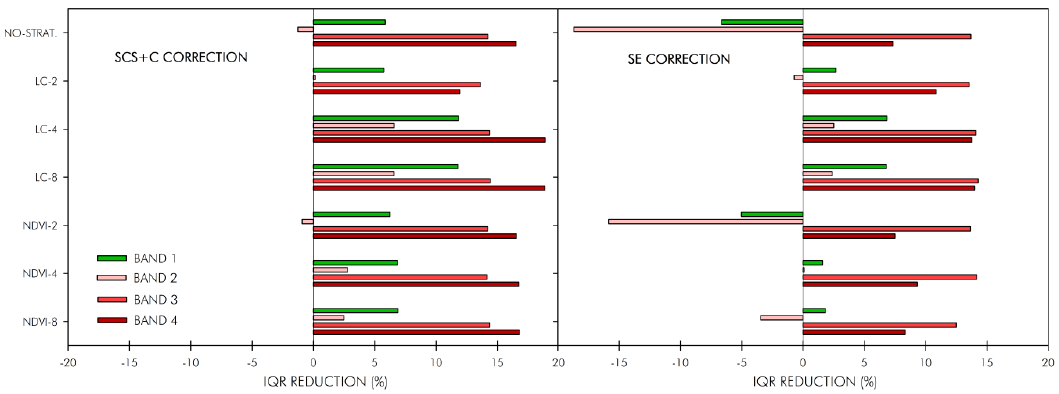
Figure 9. Mean intraclass IQR reduction. Measured as the area-weighted average of IQR reduction for eight land covers.